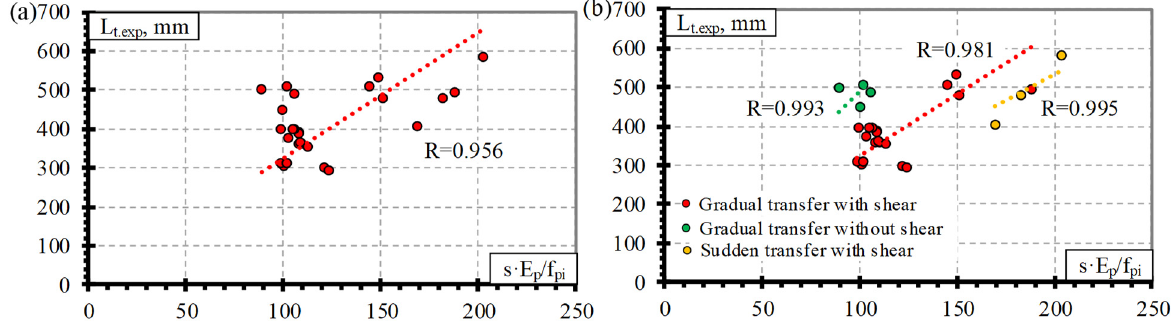
Figure 4. Comparison between the transfer length of the CFCC strands and s·E p /f pi : ( a ) all results, ( b ) effect of reinforcement release type and shear reinforcement.